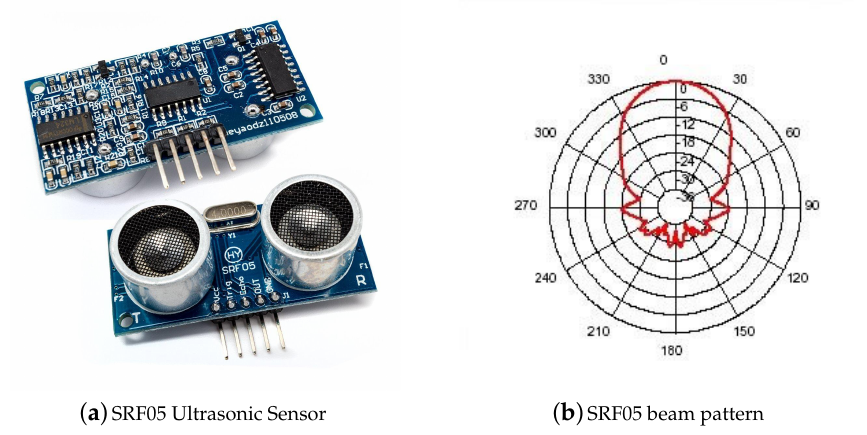
Figure 3. SRF05 ultrasonic sensor and conical beam pattern of the